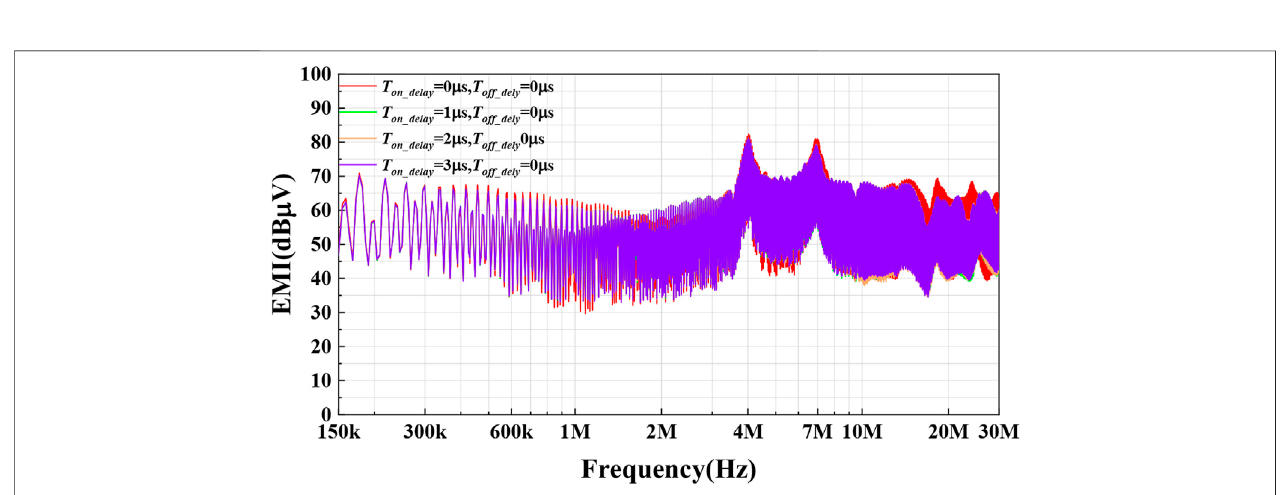
FIGURE 8 | Test results of CM EMI at different T on_delay (pattern